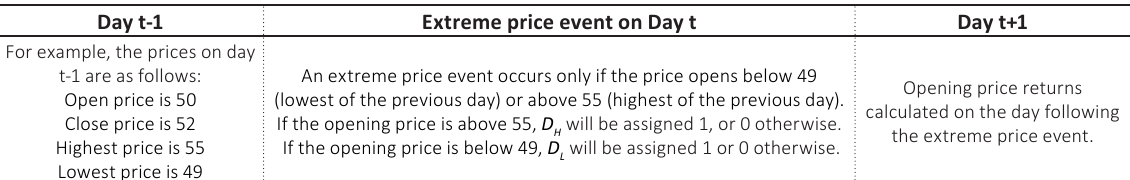
Table 2. The setup of extreme price event and returns on day t